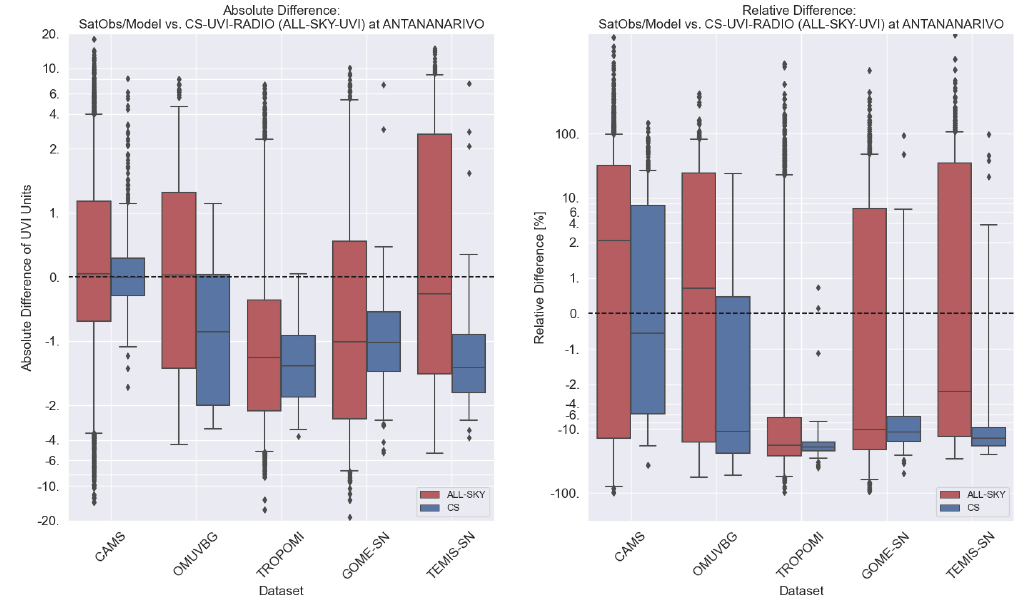
Figure A4. Boxplot of differences between UVI-RADIO and satellite/model estimates at Antananarivo.